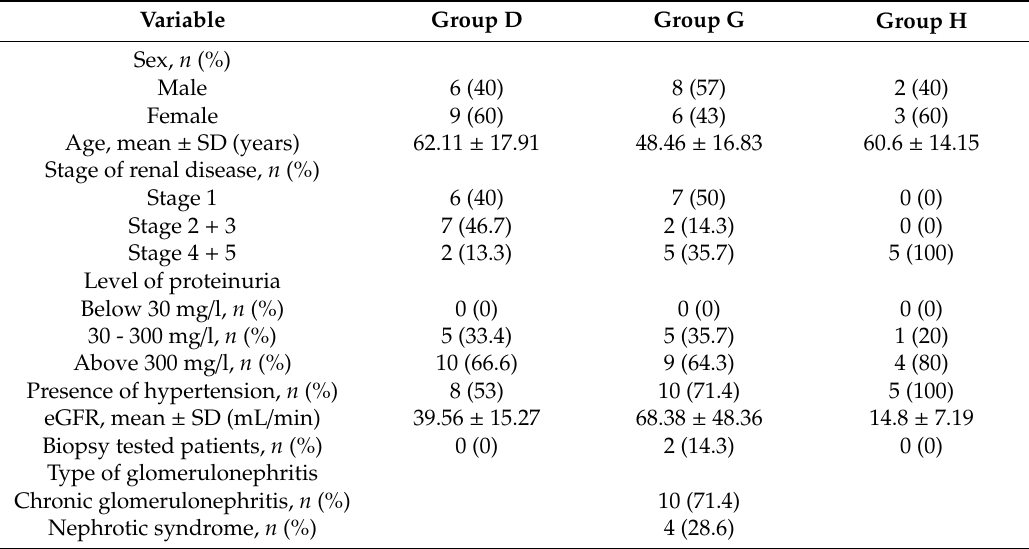
Table 1. Principal characteristics of the chronic kidney diseases (CKD) patients. Variable Group D Group G Group